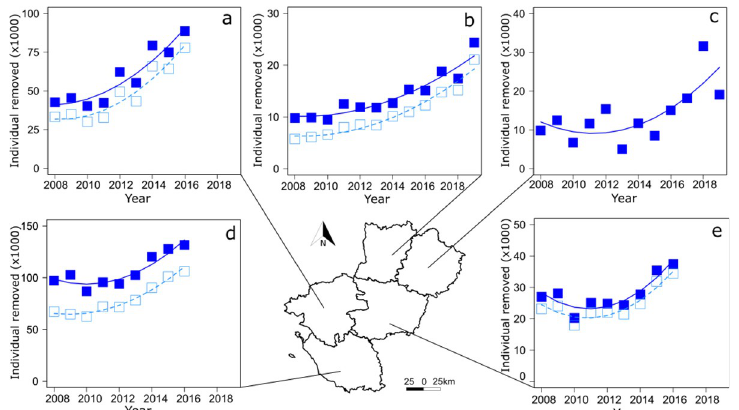
Fig 4. Variation over time of the number of aquatic invasive alien rodents (AIAR) in the 5 departments of the region Pays de la Loire. AIAR (full square) and coypus only (open square) removed in (a) Loire-Atlantique, (b) Mayenne, (c) Sarthe, (d) Vende´e, (e) Maine-et-Loire. Curved lines represent significant trends from generalized least squares (GLS) models with an autoregressive moving average term (see S2 Table for statistical details). Source of the background map: IGN GEOFLA 1 .